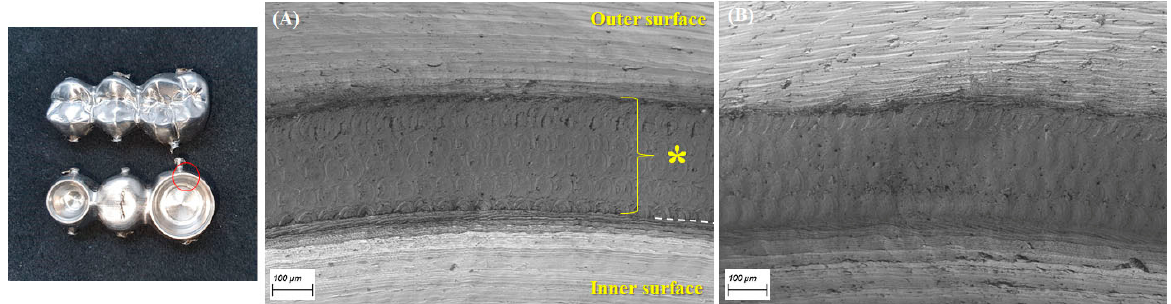
Figure 6. Scanning electron microscopy (SEM) photographs of boundary areas (asterisk marks) remained between the inner and outer milling surface at the crown margins (red circled area) of the first-milled FDP ( A ) and the sixth-milled FDP ( B ). The white dashed line ( A ) indicates the margin line at MO